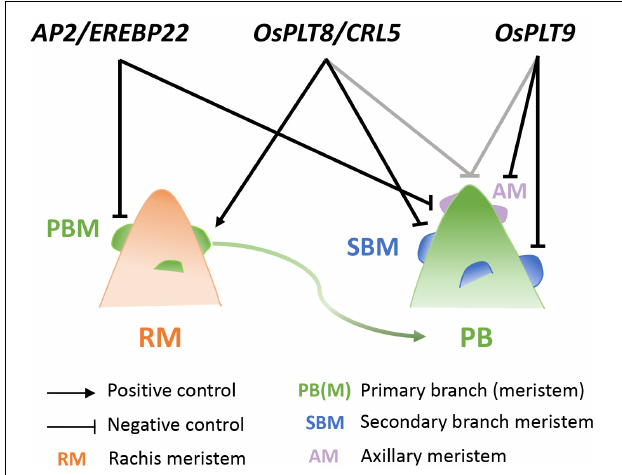
FIGURE 6 | Model of OsPLT8, OsPLT9, and AP2/ERBP22 gene interactions in panicle branching complexity in relation to meristem fate control. Schematic view of the mode of action of the OsPLT8, OsPLT9, and AP2/ERBP22 genes on the rachis (left panel) and the primary branch (right panel). Black arrow indicates a positive action on axillary meristem establishment on rachis. Blunt ends in black indicate the negative actions on axillary meristem establishment and/or axillary meristem fate transition. Blunt ends in gray indicate the negative action on the primary branch length. AM, axillary meristem (on PB); PB, primary branch; PBM, primary branch meristem; RM, rachis meristem; SBM, secondary branch meristem.